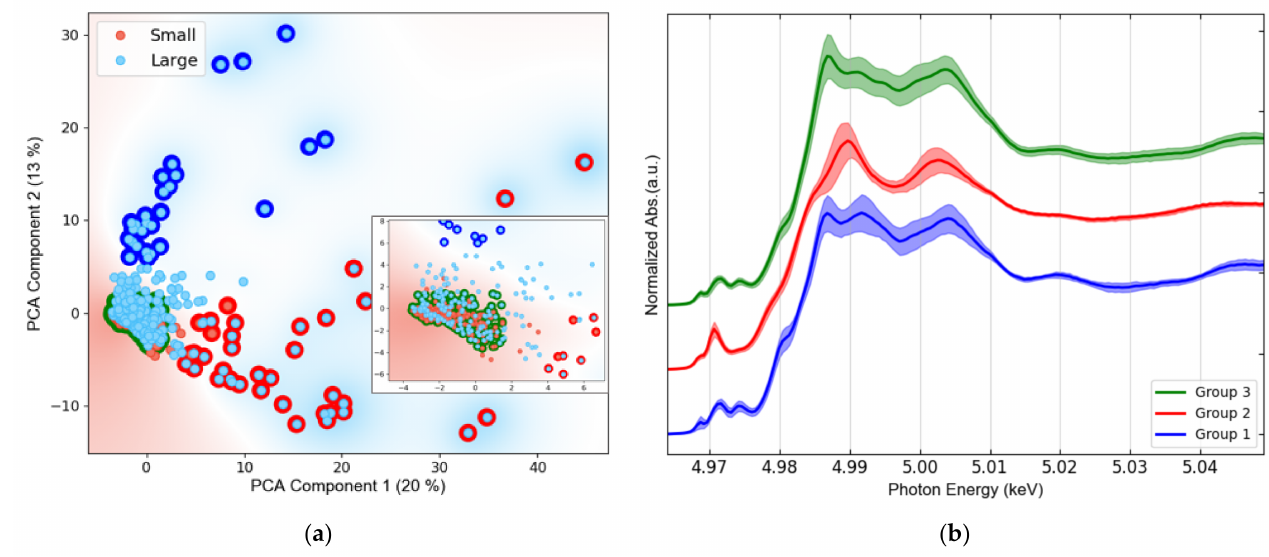
Figure 6. Results of PCA of all the Ti K-edge µ XANES spectra: ( a ) PCA scores plot, including a zoom in the region with the highest point density. Between brackets, the percentage of total variance explained by each component is reported; ( b ) Corresponding average XANES spectra of each of the three identified groups (solid line) with uncertainty bands (standard